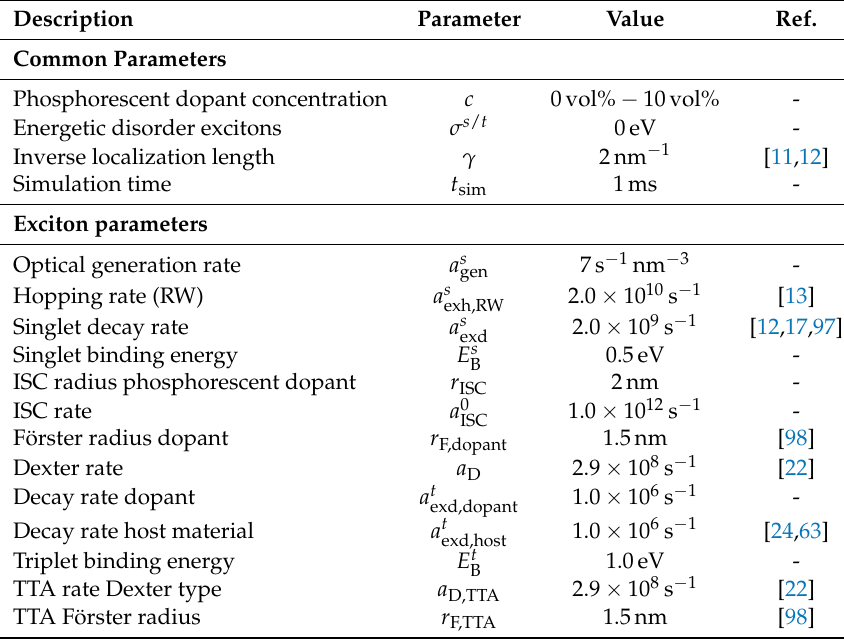
Table 2. Simulation parameters for the exciton